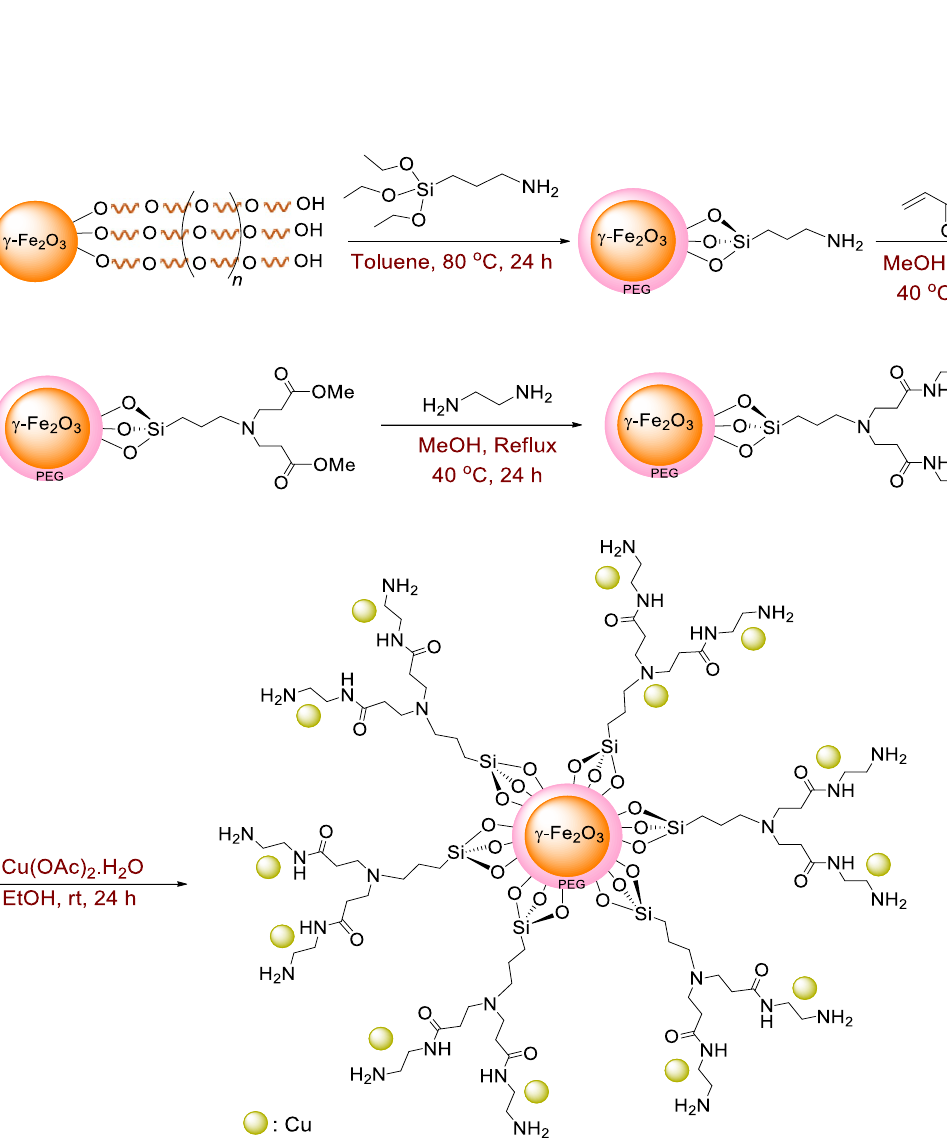
Figure 3. Preparation route for the catalyst, γ-Fe 2 O 3 @PEG@PAMAM G 0